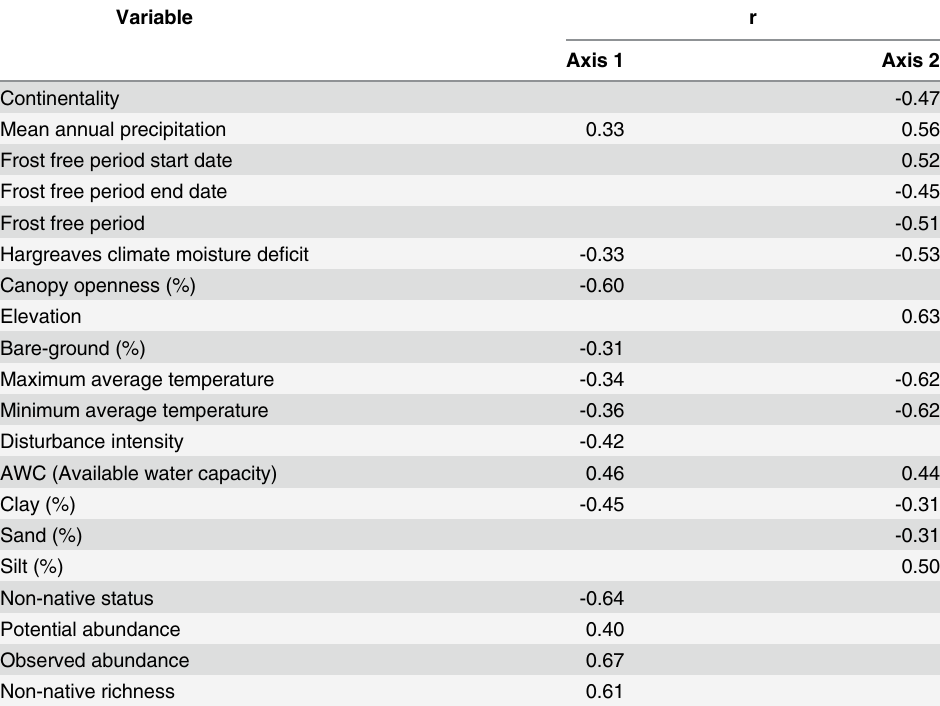
Table 2. Correlation coeffecients between environmental variables/sample unit traits and NMS ordi- nation axes. Blank cells indicate r (cid:2)